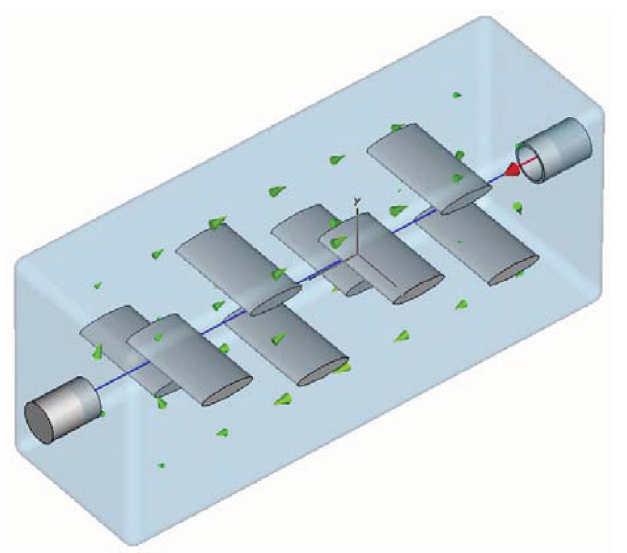
FIG. 5. (Color) Electric